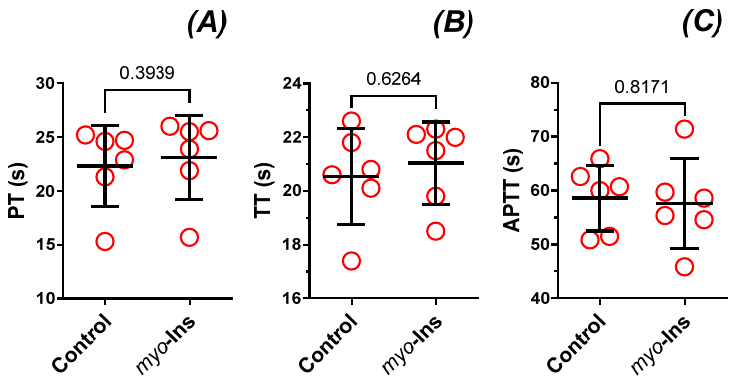
Figure 7. The effect of myo -inositol (1.0 μ M, incubation time—30 min, 37 °C) on the hemostatic parameters: the prothrombin time ( A ), the thrombin time ( B ), and the activated partial thromboplastin time ( C ) of human plasma. Data are expressed as means ± SD ( n = 6). Unpaired t test for TT and APTT, and Mann-Whitney test for PT. Abbreviations: APTT, activated partial thromboplastin time; PT, prothrombin time; TT, thrombin time.